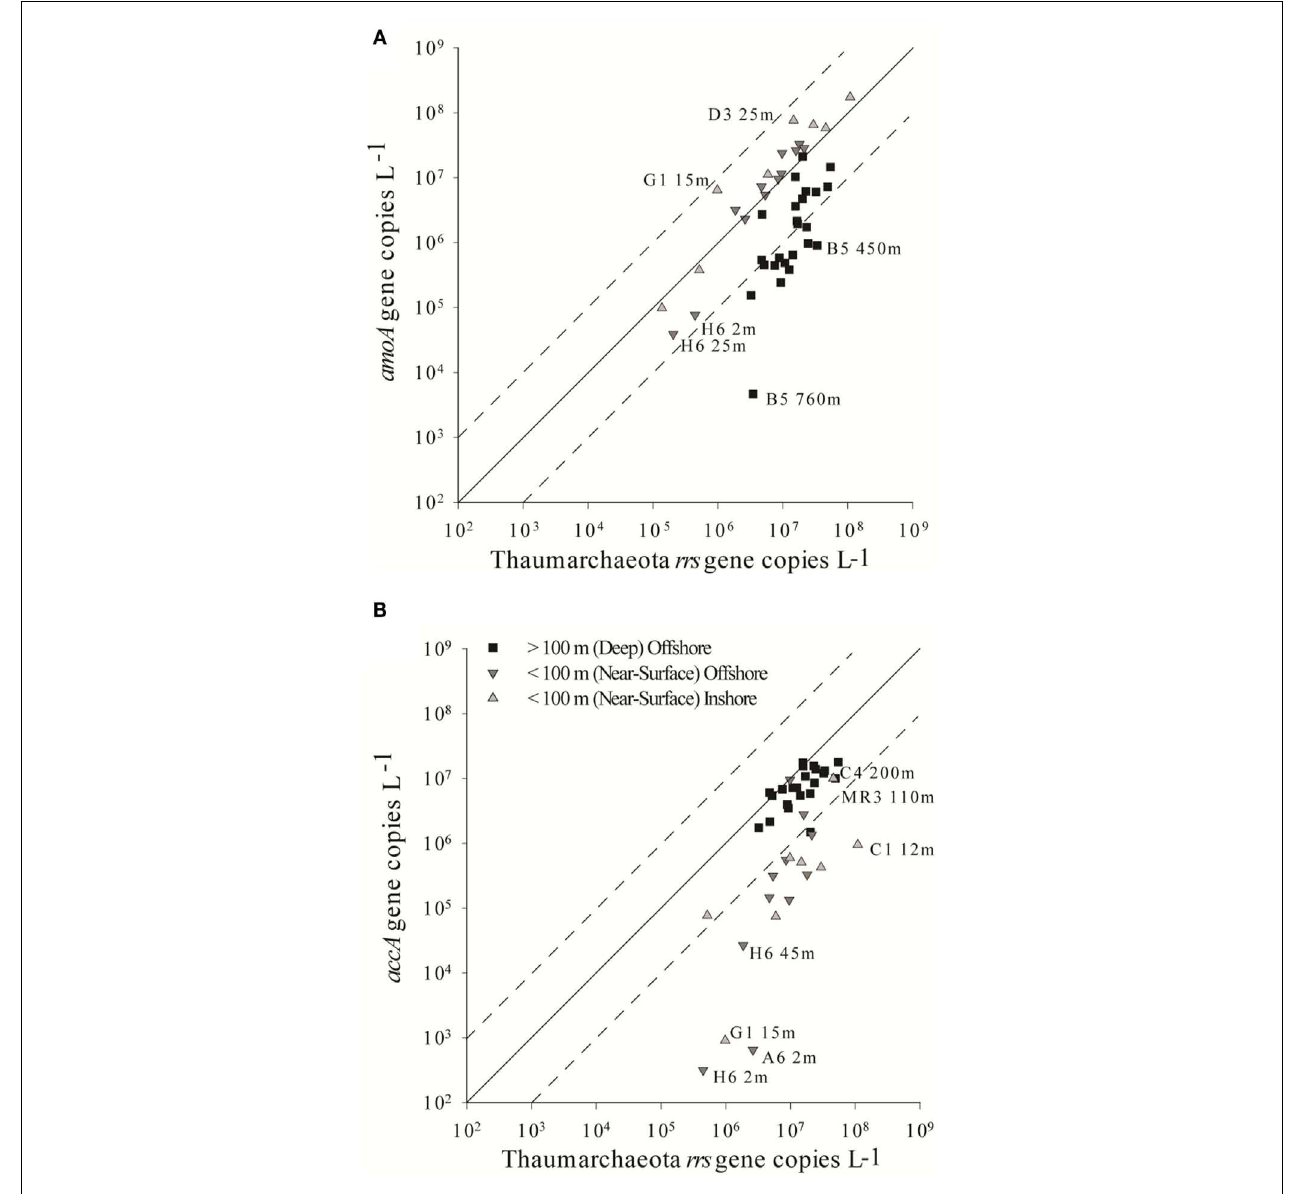
SCM1 genome (Walker et al., 2010); dashed lines indicate ratios of 0.1 or 10. “Inshore,” over the continental shelf; “offshore,” shelf break and